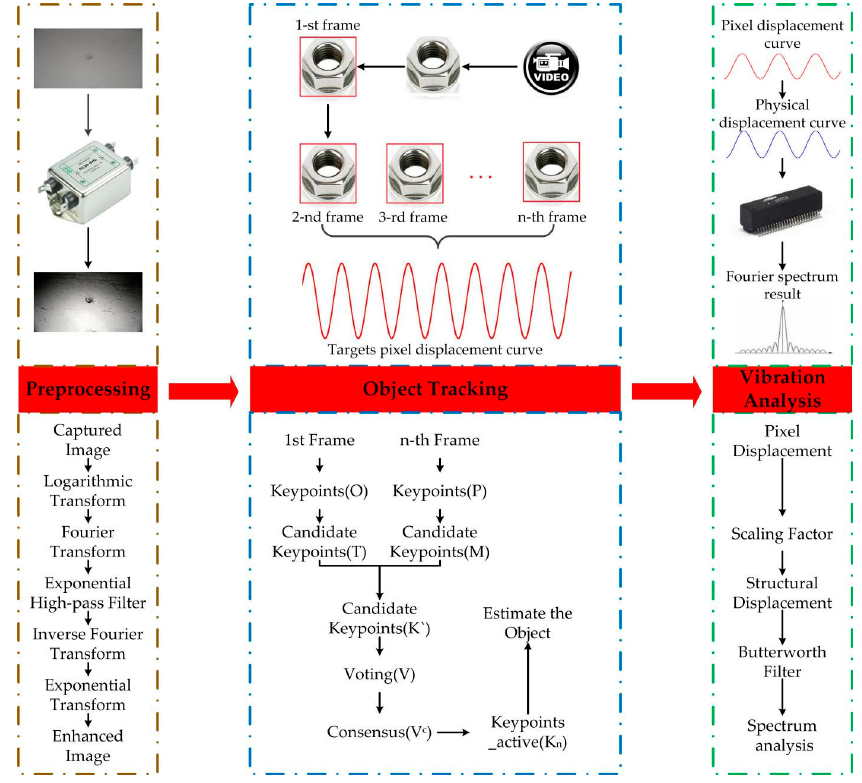
Figure 1. Vision sensor implementation procedure.